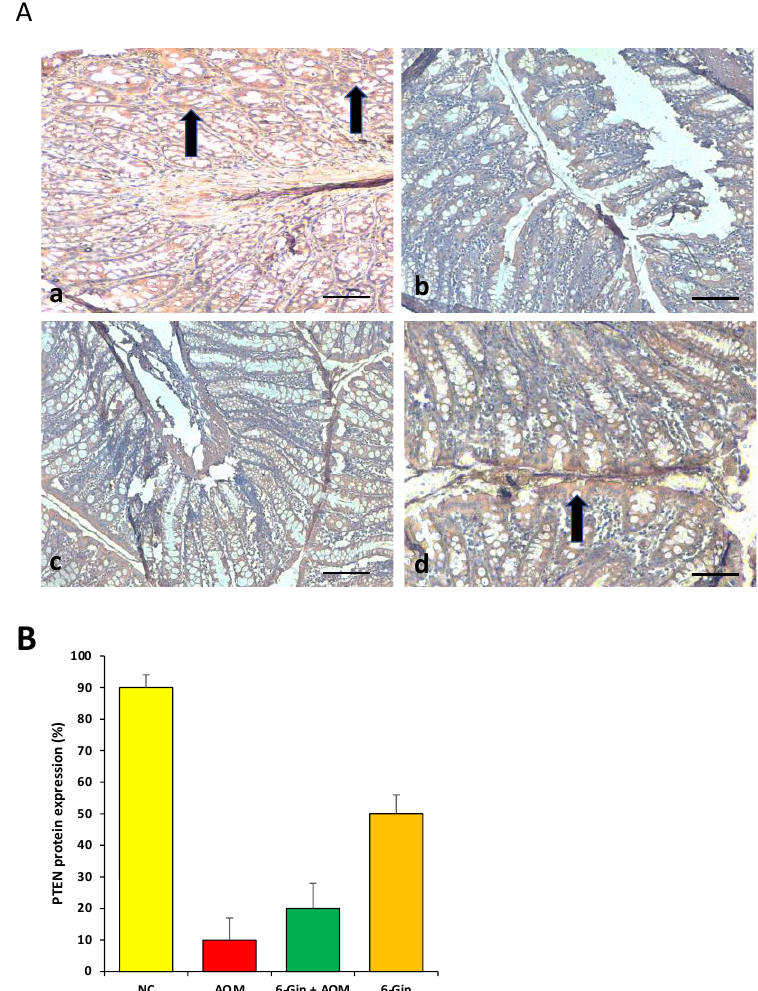
Figure 5. ( A ) PTEN protein expression analysis. ( a ) The control group showed high expression of PTEN (black arrow); ( b ) the group treated with AOM only displayed a loss of PTEN protein expression, ( c ) the expression of this marker protein was reduced in animals co-treated with both AOM and 6-gingerol together, but the positivity was less than AOM only treated group, ( d ) the animals treated with only 6-gingerol showed high expression of PTEN protein ( n = 8 animals/group) (Scale bar = 100 µ m). ( B ) Percentage of PTEN protein expression in different animal groups.